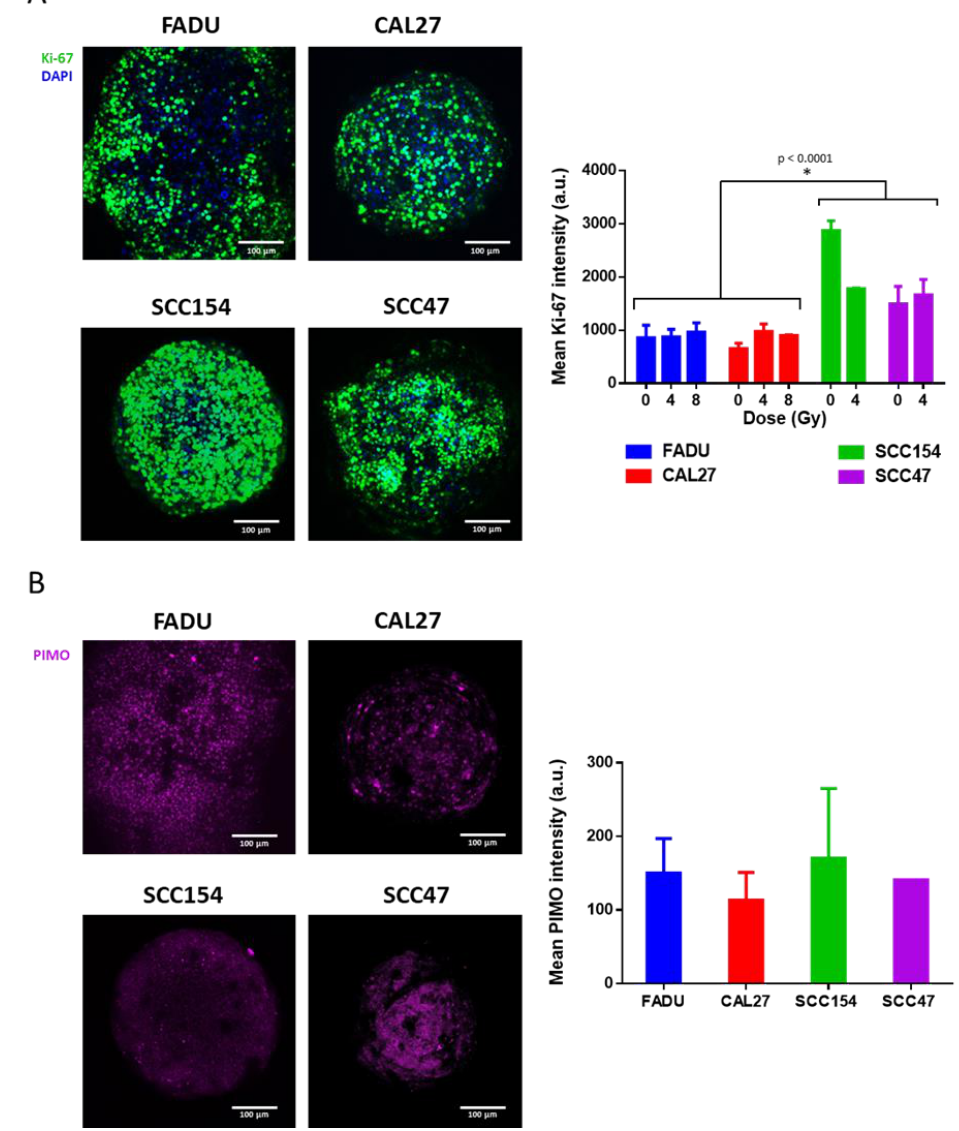
Figure 4. Proliferative capacity ( A ) and hypoxia levels ( B ) of HPV-negative and HPV-positive spheroids. ( A ) Whole-mount staining of Ki-67-positive cells (left) and mean intensity (right) in HPV- negative (FADU and CAL27) and HPV-positive (SCC154 and SCC47) spheroids at the end of the experiment. ( B ) Whole-mount staining of pimonidazole-positive cells (left) and mean intensity (right) in HPV-negative (FADU and CAL27) and HPV-positive (SCC154 and SCC47) spheroids. ( A , B ) Data are presented as mean ± s.e.m., n = 2 at minimum. p -values < 0.05 were determined by two-tailed t- test. Scale bar, 100 μm .